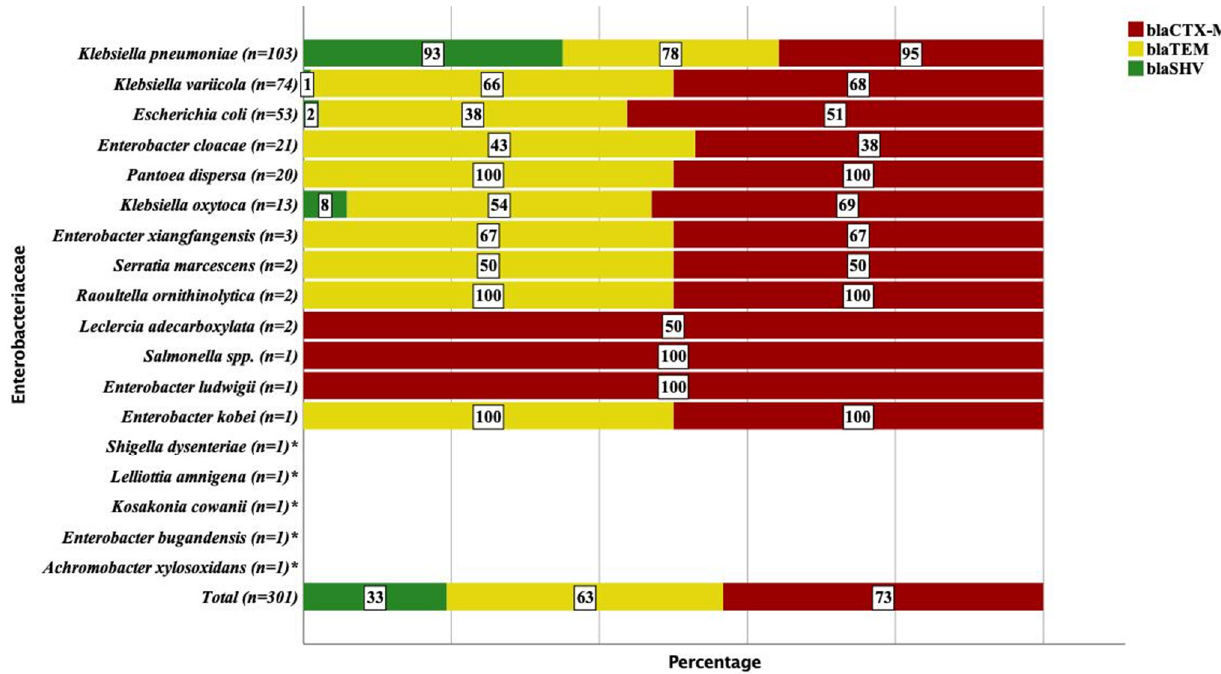
Figure 2. Frequency and distribution of Enterobacteriaceae that encoded bla CTX-M , bla TEM and bla SHV genes as detected using the whole genome sequence. * No bla CTX-M , bla TEM and bla SHV detected .